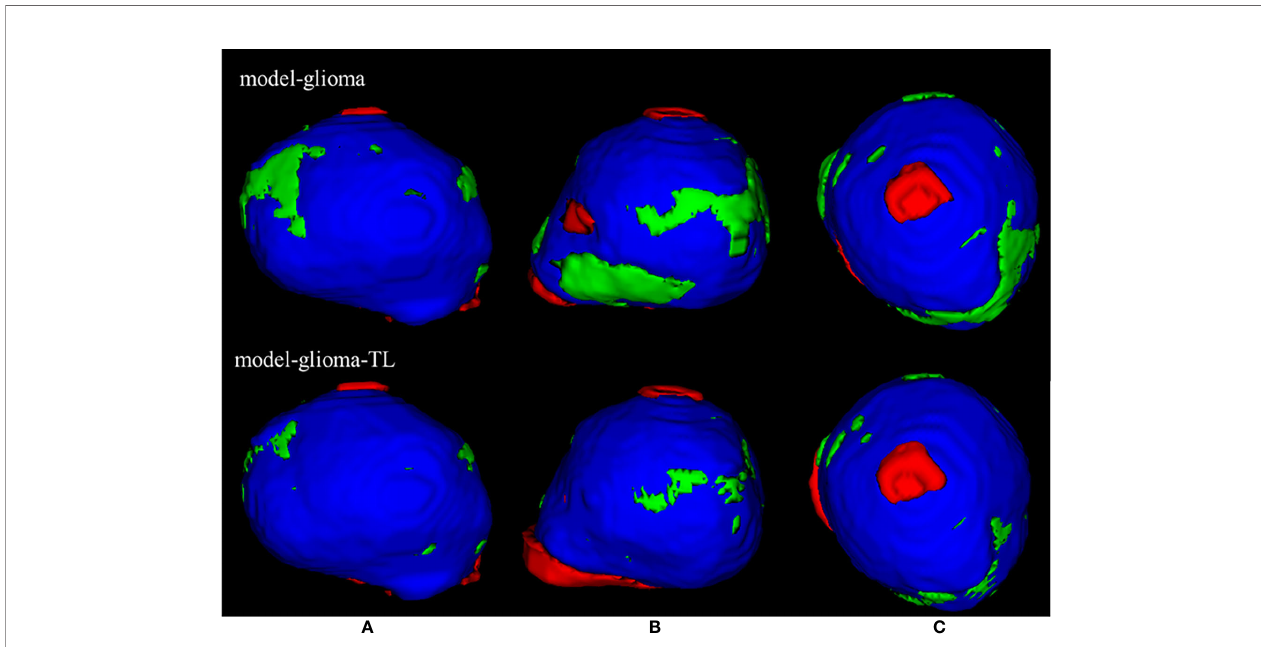
FIGURE 6 | | The 3D visualization of the test samples for the two models. The red region is the individual contouring by human experts, the green region is the individual contouring by AI models, and the blue region is the mutual contouring combined with human experts and AI models. The contouring by model-glioma-TL coincided with the contouring by human experts better than that of model-glioma in three different pro fi les of the test sample (A – C) . And the mean absolute percentage error of model-glioma-TL in the autosegmentation of glioblastoma GTVs with the same test set was 2.58% and superior to 4.74% of